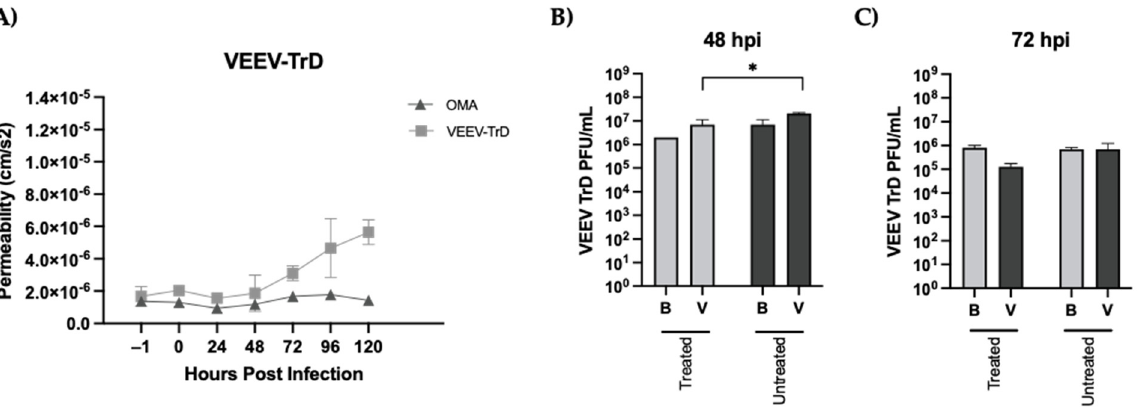
Figure 7. Impact of OMA treatment on the BBB permeability and viral load in the gNVU in the context of VEEV TrD infection. ( A ) gNVUs that were infected (TrD[MOI:0.1]), untreated (n = 3) or infected and treated with OMA (0.5 µM) (n = 3) were assessed for endothelial permeability status by quantification of FITC-dextran in the brain and vascular chambers. Permeability is depicted as variables of porous membrane units and time (cms/s 2 ) and is the average of three independent data points for each time point represented; ( B , C ) the perfused media obtained from the brain and vascular compartments of the infected, untreated and infected treated gNVUs at 48- and 72-h post infection were used to quantify infectious viral titer by plaque assay. Data represent average of three independent samples and titers are expressed as PFU/mL. Statistical analysis was carried out using t -test * p < 0.05.